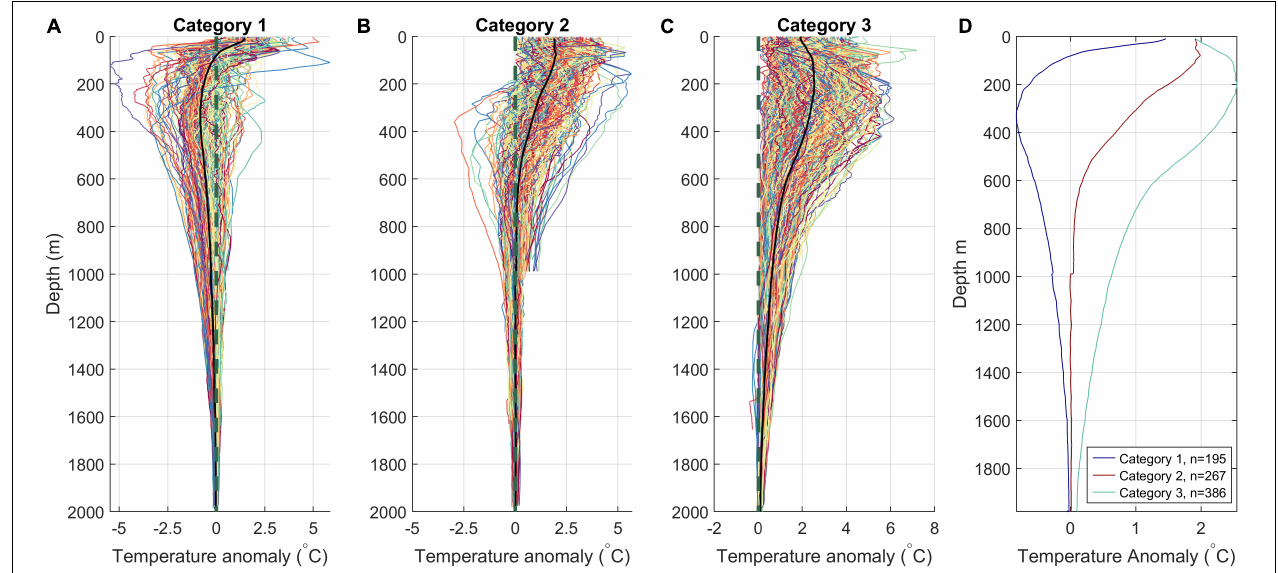
FIGURE 6 | Individual (colored lines) and mean (thick black lines) depth profiles of temperature anomalies during MHWs of category 1 (A) , 2 (B), and 3 (C) . Gray dashed line shows the positive threshold anomaly. Panel (D) shows the mean temperature anomaly profile per MHW category with the number of Argo profiles per category indicated in the legend.